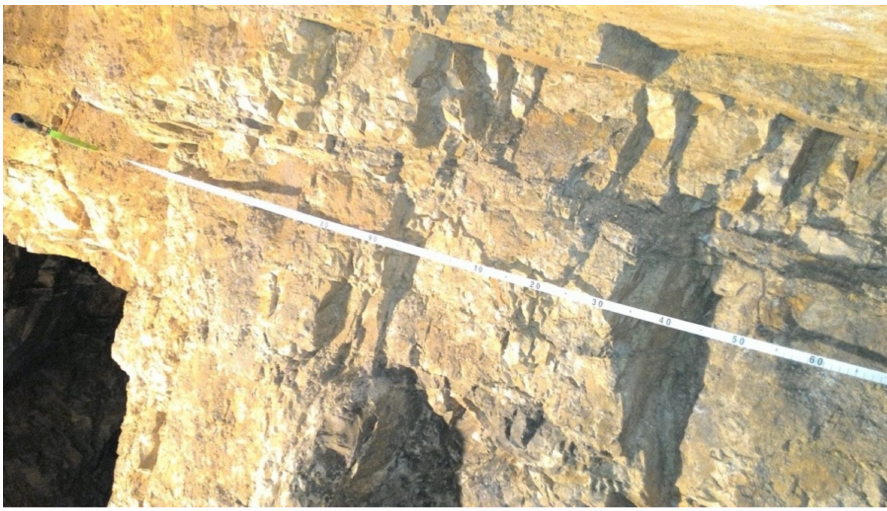
Figure 3. Geo-mechanical survey with the scan-line method